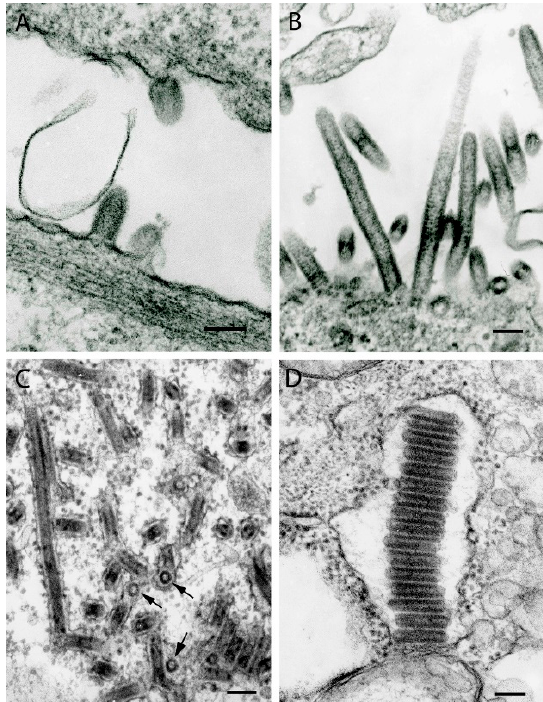
Figure 2. Ultrastructure of viruses of the family Rhabdoviridae . ( A ) Harlingen virus, strain PV01-3828 (unclassified; proposed genus Barhavirus ). Short virions (120–140 nm long, 80 nm in diameter) budding from the surface of Vero E6 cells. ( B ) Sweetwater Branch virus, genus Tibrovirus . Long virions (530 nm to 690 nm and up to 900 nm long, 65 nm to 75 nm in diameter) budding from the cell surface. ( C ) Boteke virus, (unclassified; probable genus Vesiculovirus ). Virions forming inside individual intracytosolic vacuoles in a C6/36 cell. Virions are ~45 nm in diameter and up to 780 nm long. Arrows indicate cross-sections of the virions. ( D ) Niakha virus, strain DakARD88909, genus Sripuvirus . A stack of virions 800 nm long in an expanded granular endoplasmic reticulum cistern. Each virion is 55 nm in diameter and 190–215 nm long. Bars = 100 nm.